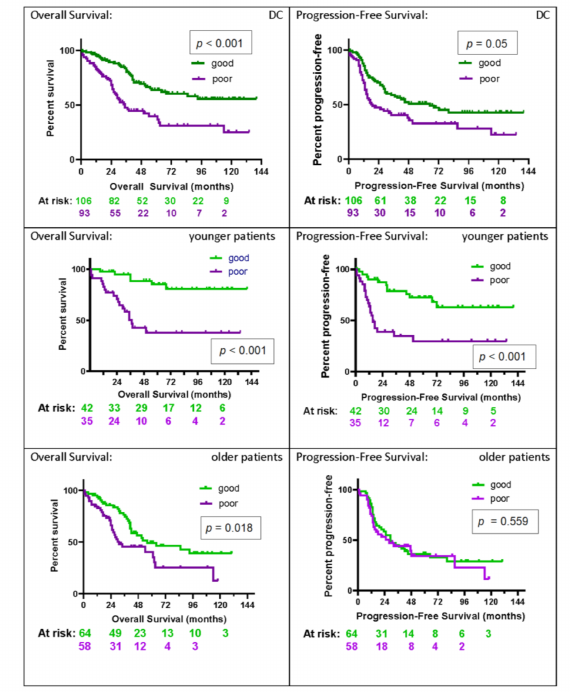
Figure 2. Kaplan–Meier (KM) plots by test classification (good vs. poor) of overall and progression-free survival for the development cohort (DC): overall (DC, n = 199) and for younger patients (age ≤ 55, n = 77) and older patients (age ≥ 56, n = 122) separately. The number of patients at risk in the KM analysis at two-year intervals in each test classification group (green = good, and purple = poor) is shown below the x